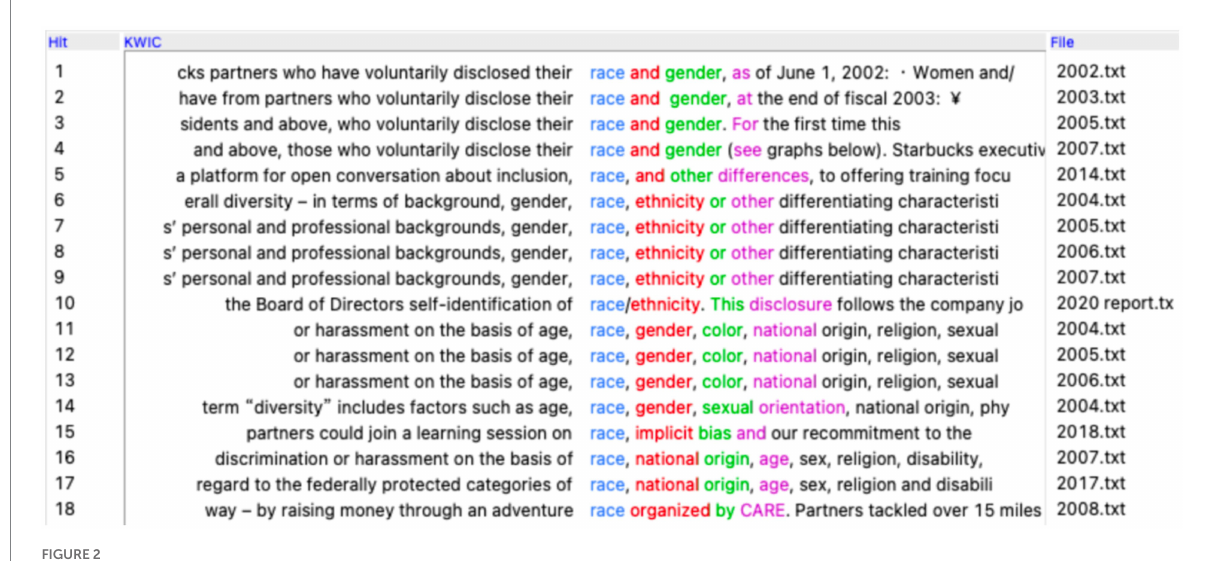
FIGURE 2 Concordance lines of ‘race’ in Starbucks’ CSR reports. Reproduced from Antconc (Anthony,